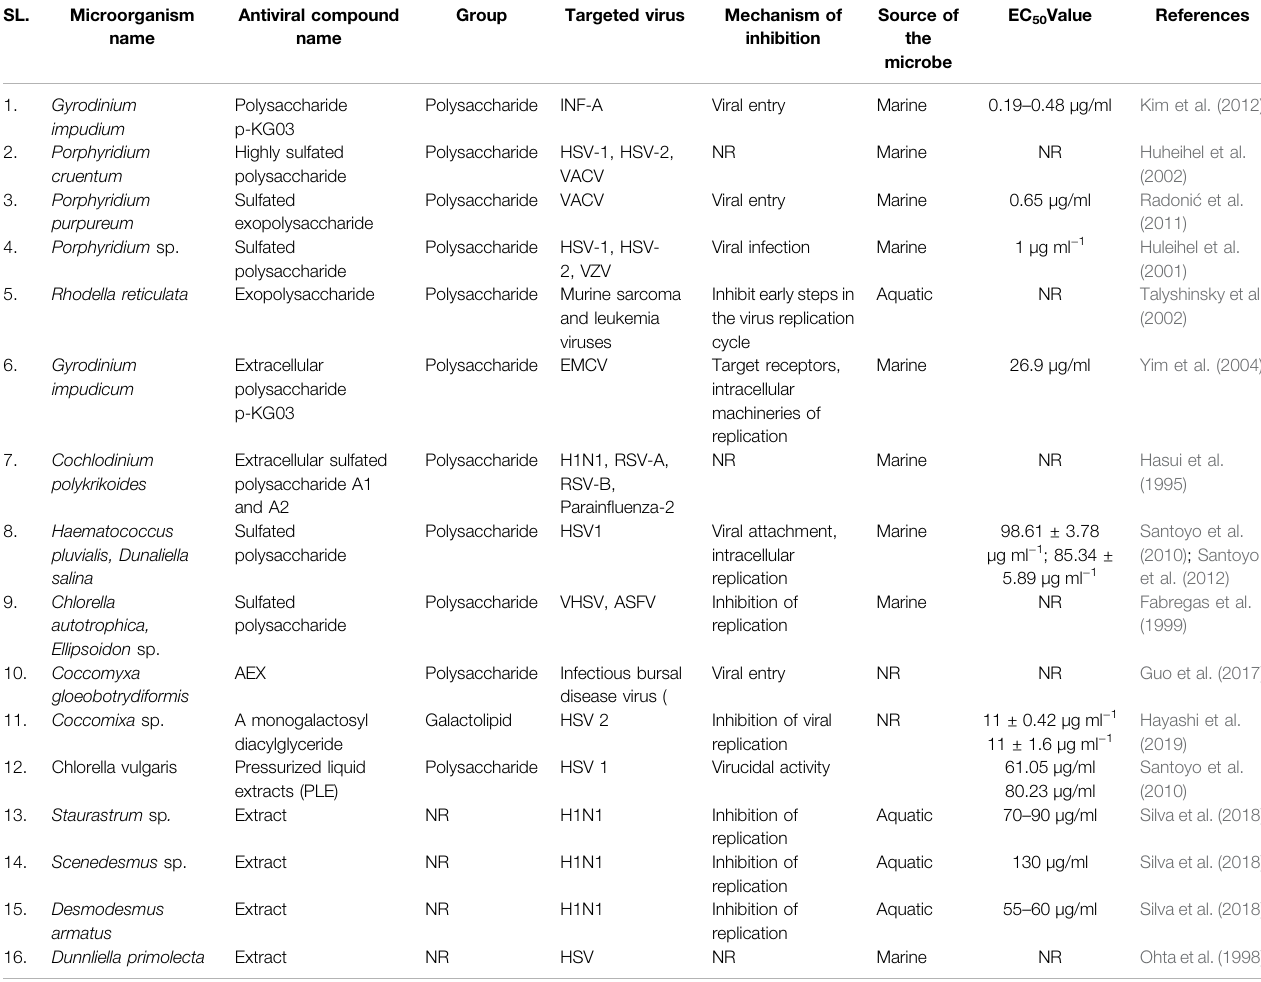
TABLE 3 | Antiviral bioactive compounds obtained from microalgae. SL.